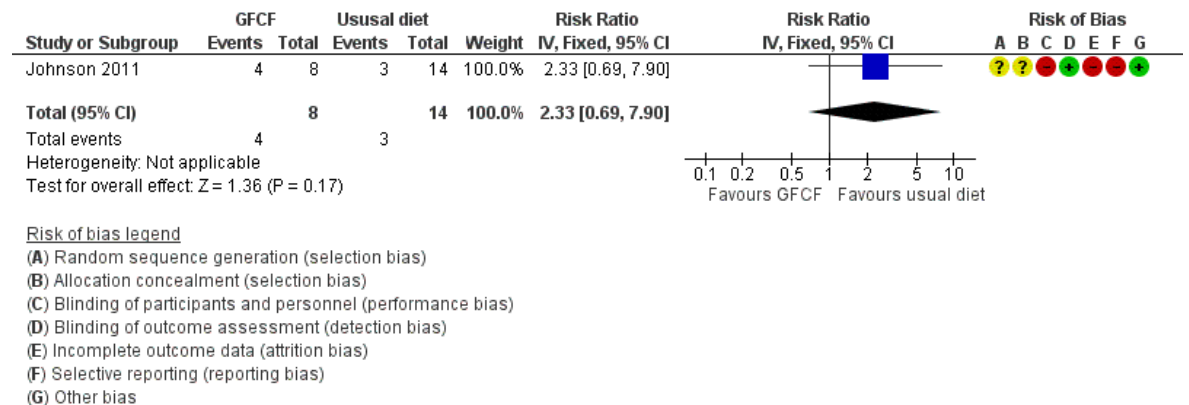
Figure 7. Forest plot of comparison: GFCF vs. usual diet, outcome: parent-reported functional level (VABS daily living, higher is better). Figure 8. Forest plot of comparison: GFCF vs. usual diet, outcome: parent-reported child’s behavioral difficulties (CBCL Aggression subscale, lower is better).